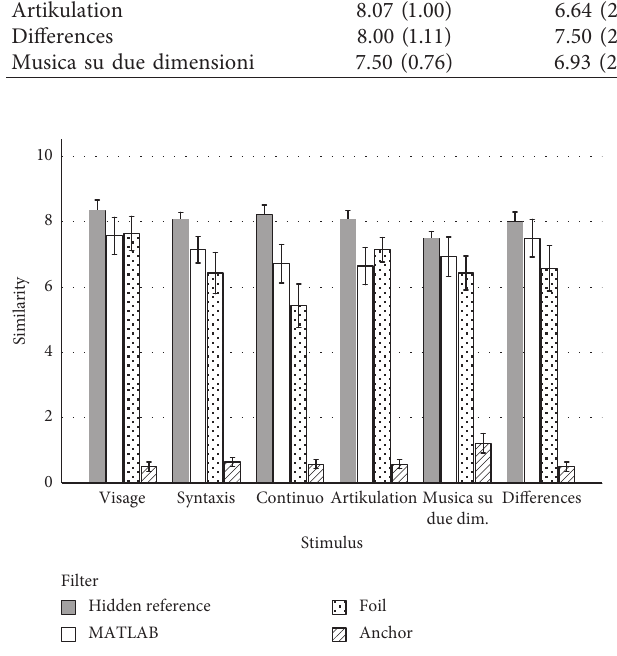
Figure 4: Mean similarity ratings by stimulus and filter ( n � 14). Error bars are equal to ± 1 SE